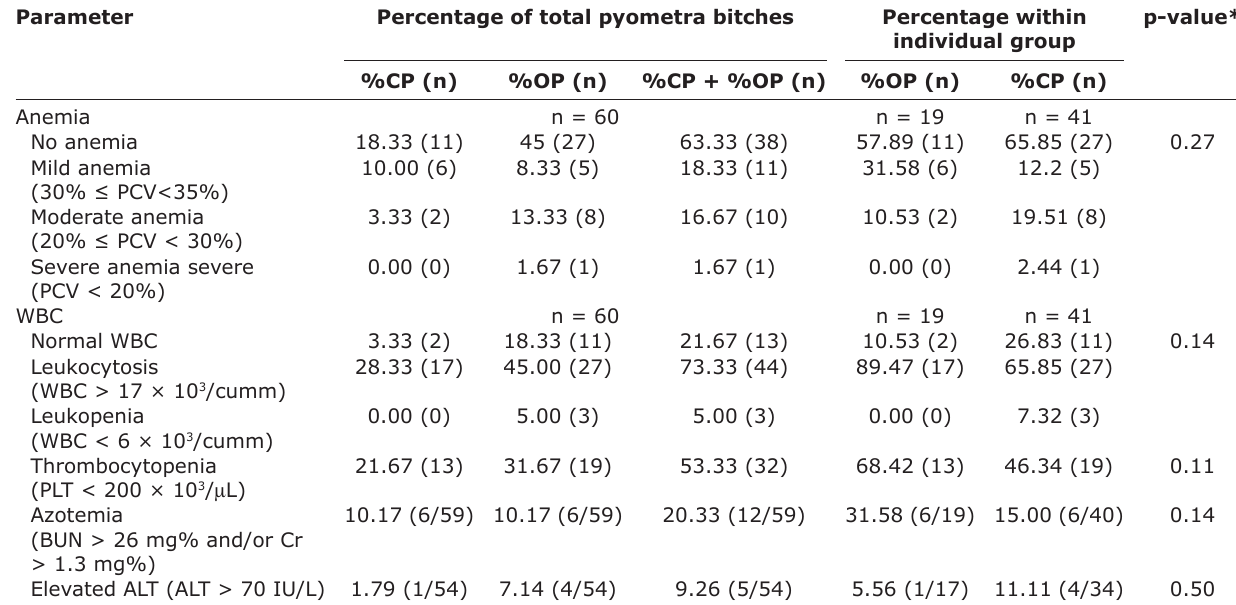
Table-5: Percentages of hematological parameters and blood biochemistry levels in total pyometra bitches (n = 60) and within CP (CP, n = 19) and OP (OP, n = 41) groups. Parameter